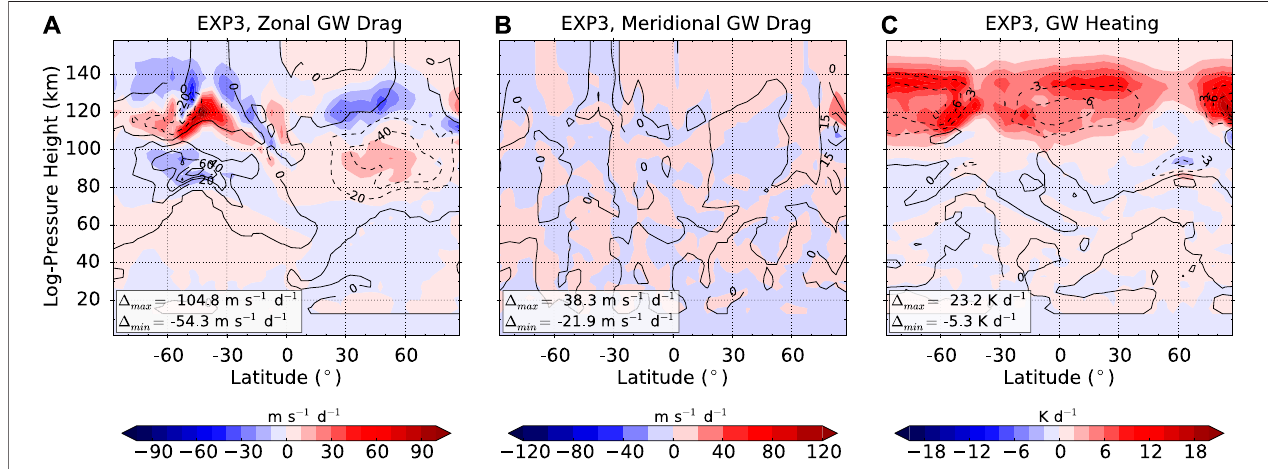
FIGURE 7 | Same as Figure 6 but for (A) zonal GW drag, (B) meridional GW drag, and (C) heating due to GWs in intervals of (A) 20 m s − 1 d − 1 , (B) 15 m s − 1 d − 1 , and (C) 3 K d − 1 .